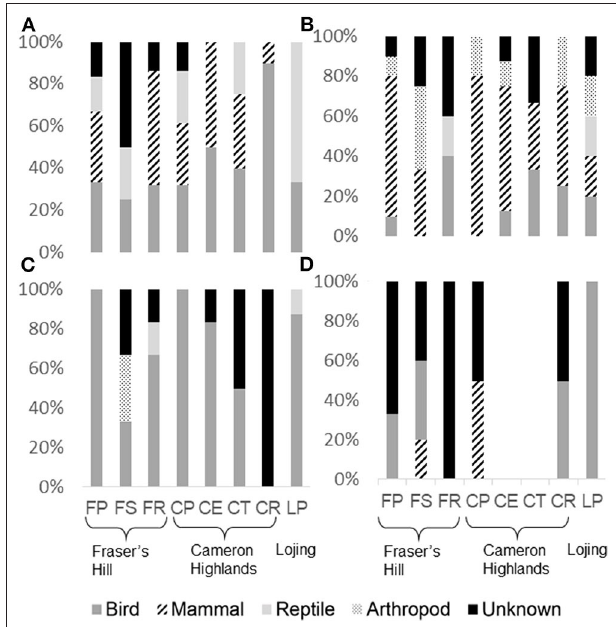
FIGURE 2 | Proportion of each predator type for (A) artificial nests; (B) artificial seeds (C) caterpillar models; and (D) frog models. Sites are clustered together according to their respective mountain range and presented in an order of increasing canopy cover (see Table 1 ). For abbreviations, refer to Table 1